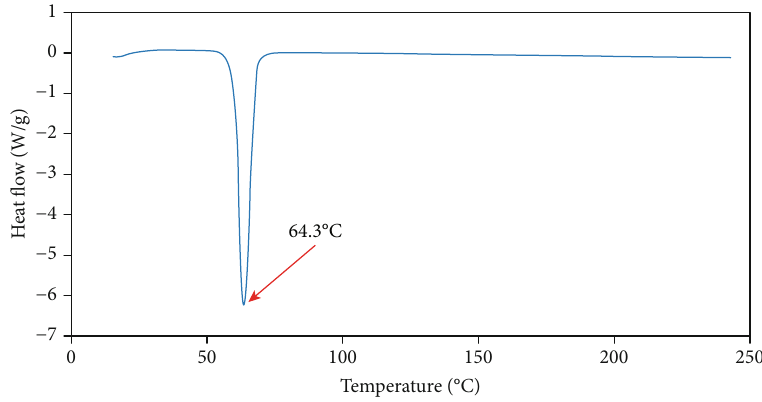
Figure 7: Heating fl ow rates versus temperature for PEG.